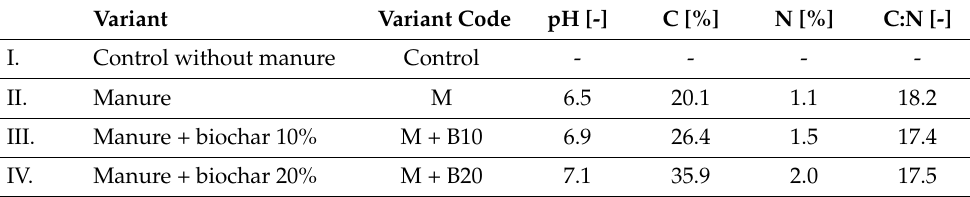
Table 1. The tested variants in the pot experiment and manure properties (in fresh matter).